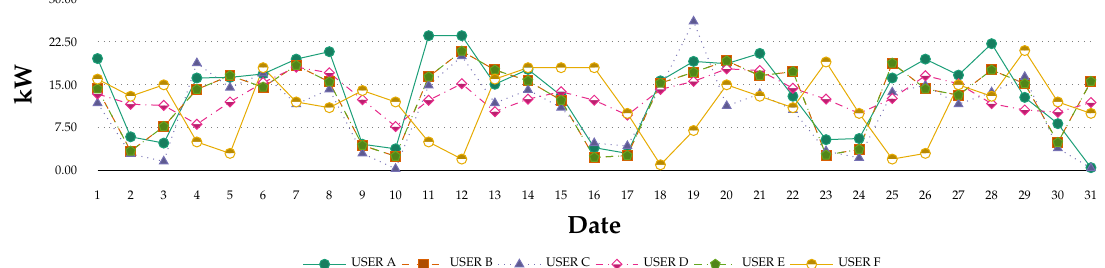
Figure 11. Consumption patterns of the daily usage of the six evaluated users over the month of July.